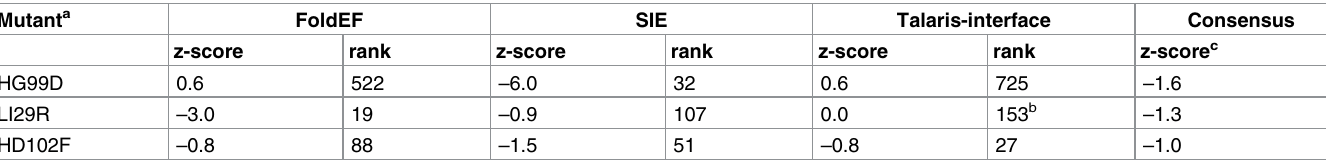
FOLDEF and SIE are (z-score –0.8, rank 88) and (z-score –1.5, rank 51), respectively. The con- sensus z-score was –1.0 bringing it within the top 50. The use of the consensus z-score allowed us to retain these single mutants as candidates for experimental validation. They eventually ended up as being part of the best triple mutants and would likely have been missed in the Table 2. Individual scoring function z-scoresand ranks for selected single mutants. Mutant a FoldEF SIE Talaris-interface Consensus z-score rank z-score rank z-score rank z-score c HG99D 0.6